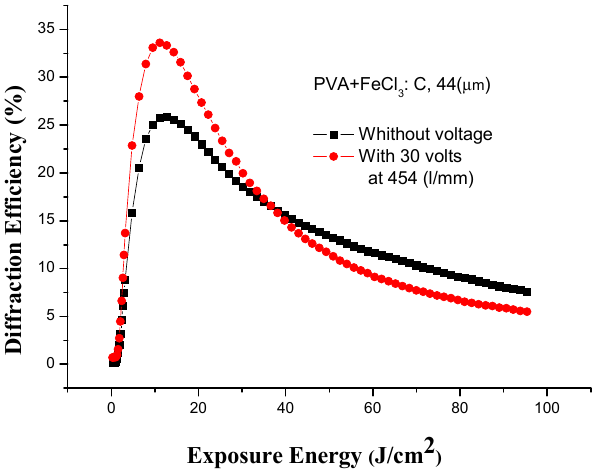
Figure 11. First-order diffraction intensity vs. exposure time with and without an applied voltage of 30 V for grating with 454 lines/mm, made from sample C.